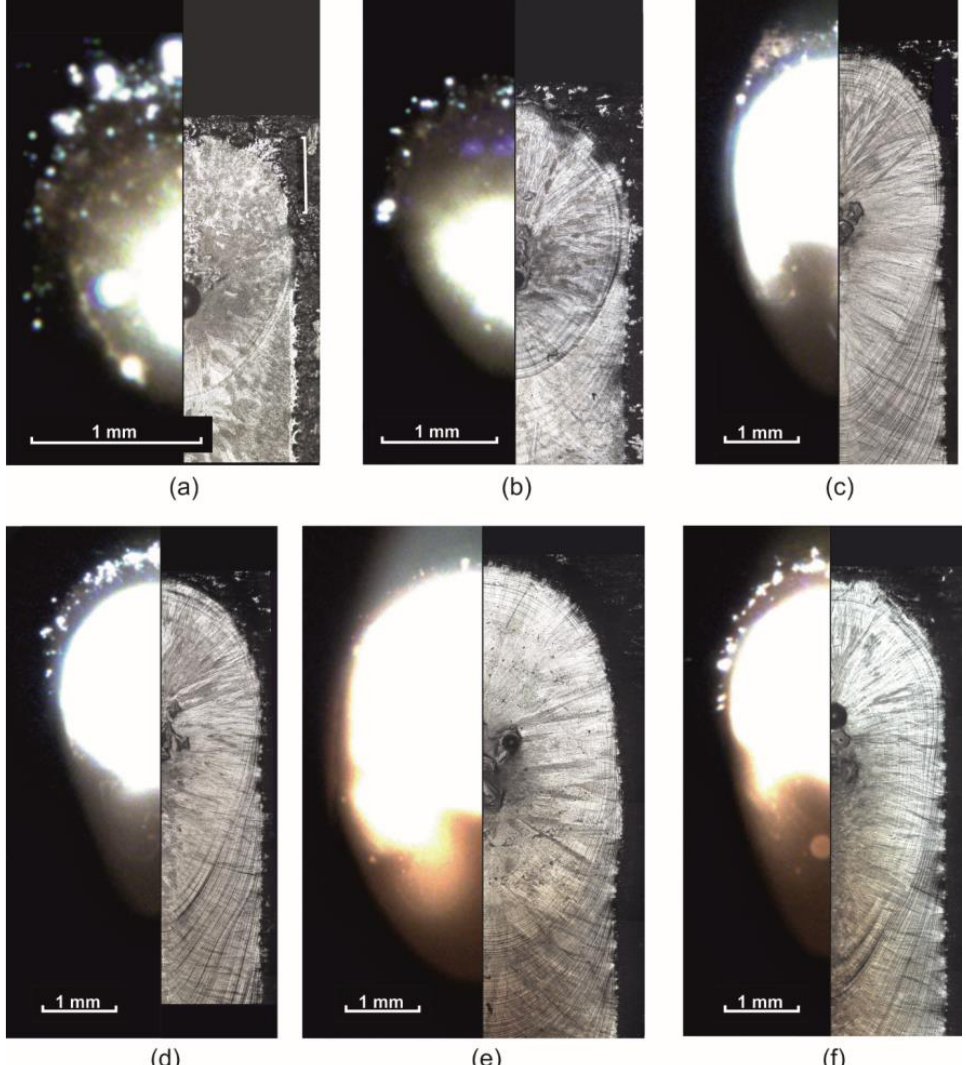
Figure 7. A series of melt pool images for various mode parameters taken using a coaxial camera (left) and the result of crystallization (right). Mode parameters: ( a ) 800 W, 20 mm/s; ( b ) 1000 W, 20 mm/s; ( c ) 2000 W, 20 mm/s; ( d ) 2000 W, 30 mm/s; ( e ) 2500 W, 10 mm/s and ( f ) 2500 W, 30 mm/s.